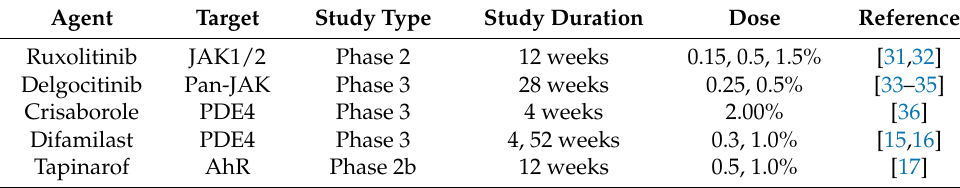
Table 2. Emerging Topical